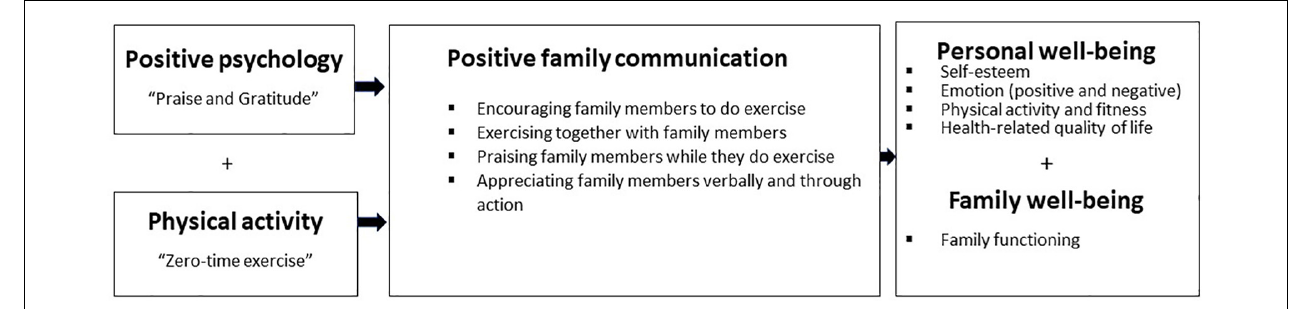
FIGURE 1 | The conceptual framework of the family holistic health